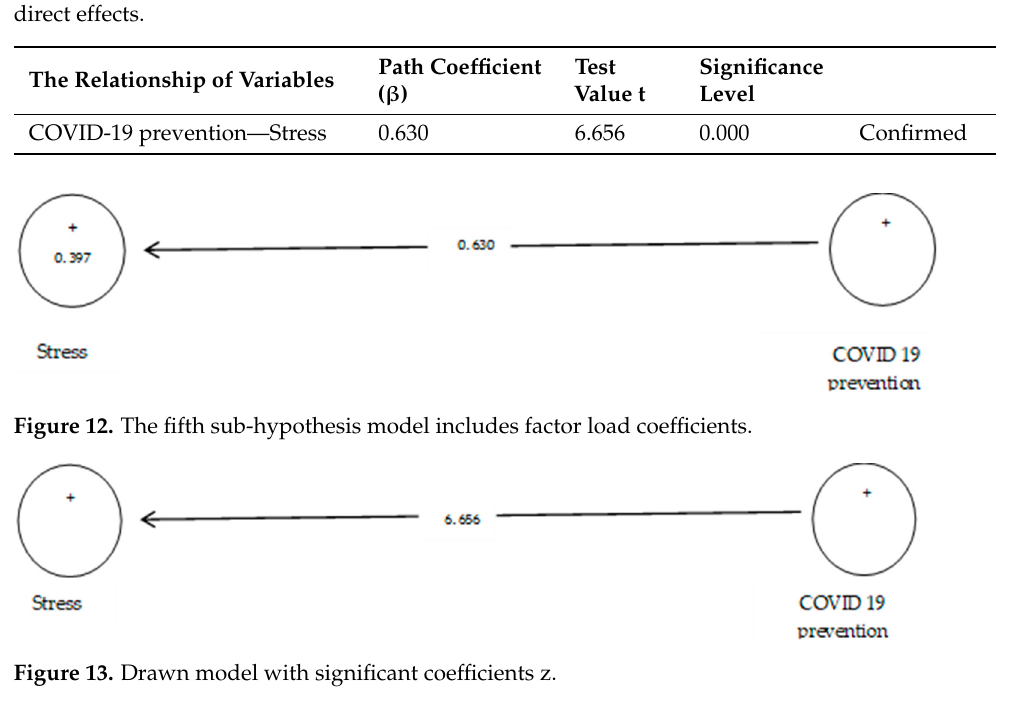
Table 8. Evaluation indicators of the internal model of the research, direction, and significance of direct effects.